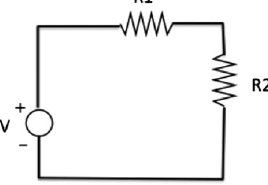
FIG. 13. Circuit for Appendix B, item